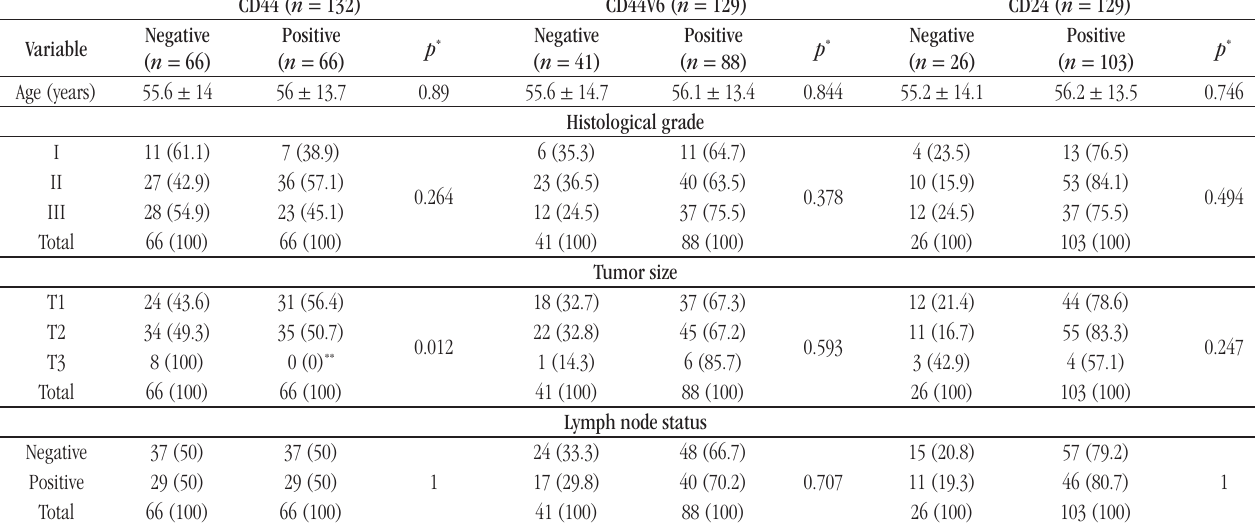
taBLE 5 − Clinicopathological characteristics and CD44, CD44v6, and CD24 expression